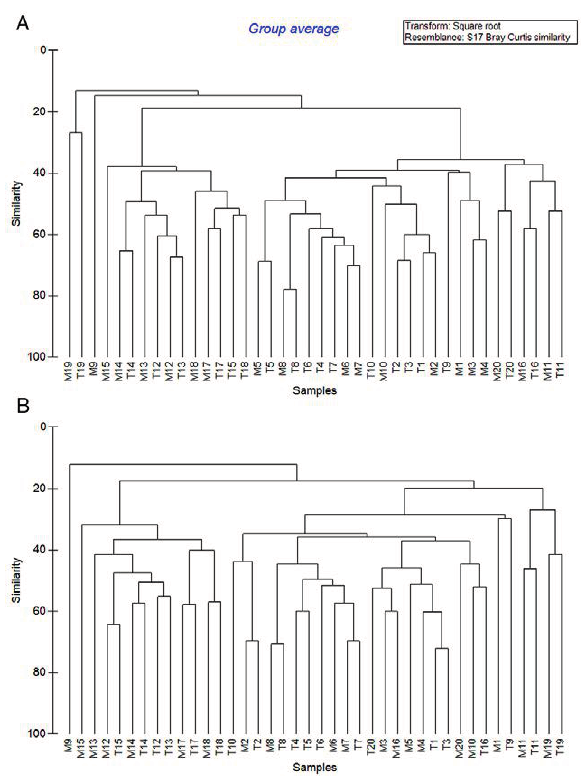
Fig. 4. – MDS plot (square root transformed data) of the abundance (A) and biomass (B) of discarded species caught in 19 trips with the Fig. 3. – Dendrogram (square root transformed data) of the abun- two types of net by season (autumn or dance (A) and biomass (B) of all species caught in the 20 trips with the two types of net: M, modified trammel net; T, standard trammel net.